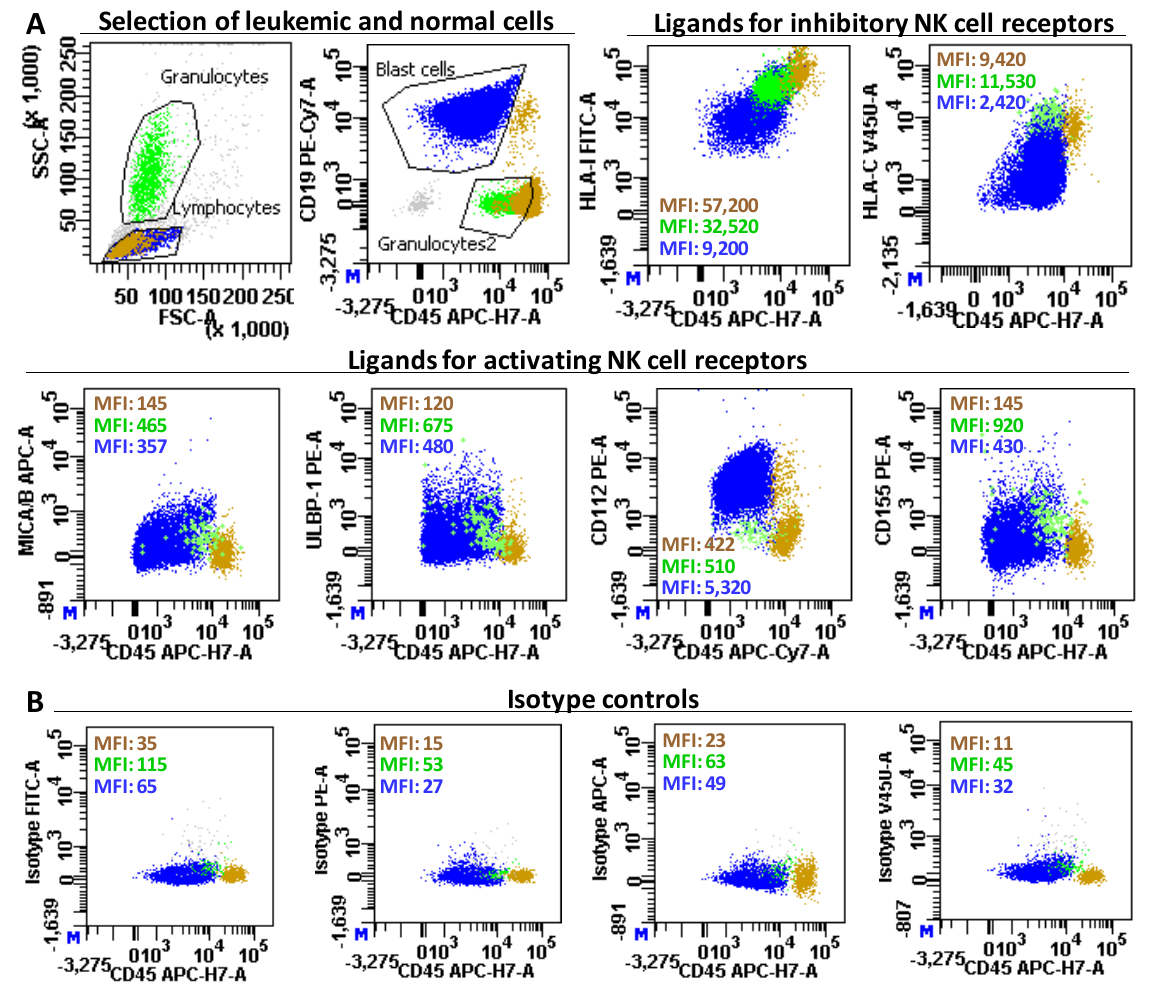
Figure 7. Immunophenotype analysis of NK cell receptor ligands in normal and leukemic bone marrow cells. ( A ) Events with low/intermediate dispersion in FSC/SSC, including residual normal lymphocytes (brown dots) and leukemic blast cells (blue dots), were gated in an FSC/SSC dot plot. Leukemic cells were gated in a plot with CD45-APCCy7 combined with CD19-PECy7 for B-ALL, CD7-PECy7 for T-ALL or CD34-PECy7 or CD33-PECy7 for AML. Granulocytes (green dots) were identified with gates on high SCC in the FSC/SSC dot plot and low CD45 in the CD45-APCCy7/PECy7 dot plot. Mean fluorescence intensity (MFI) was evaluated for CD112, CD155, and ULBP-1 in the PE-channel, for MICA/B in the APC-channel, for HLA-I in the FITC-channel, and for HLA-C in the V450 (VB421) channel on lymphocytes, granulocytes, and blast cells. Dot-plots correspond to a representative case with a clear expression loss of HLA-I and HLA-C and strong gain of CD112, with a moderate gain of MICA/B, ULBP-1, and CD155. ( B ) MFI in the FITC, PE, APC, and V450 (BV421) channels were also estimated for leukocyte subsets in the isotype tube to determine the background of each fluorescence.